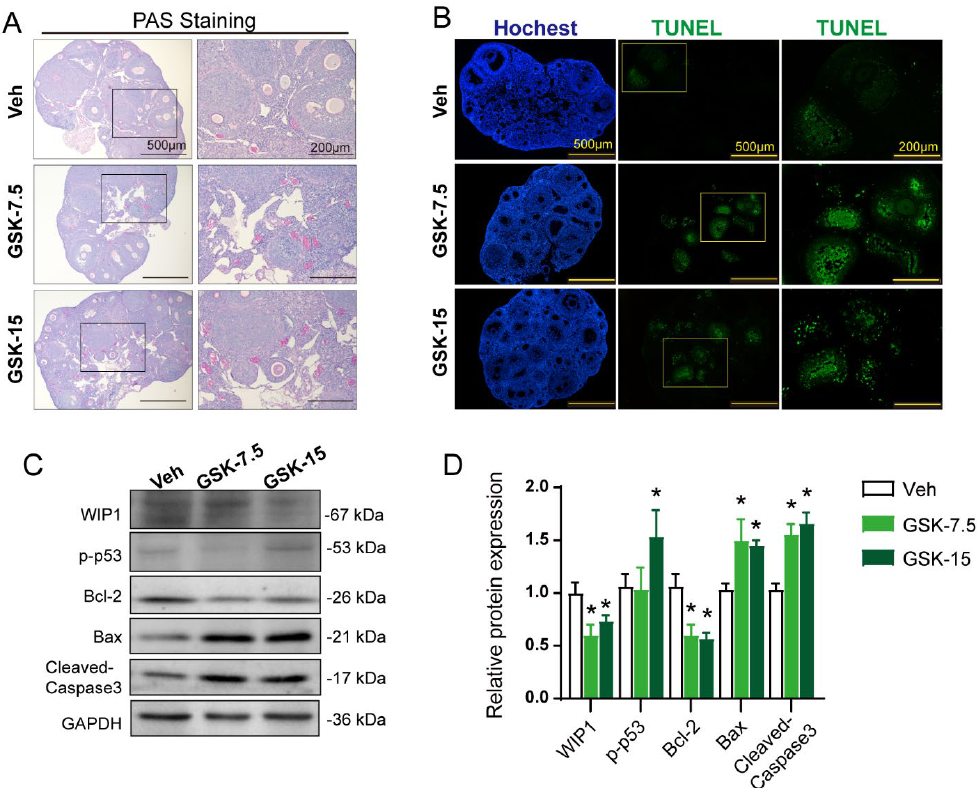
Figure 4. WIP1 inhibitor treatment promoted follicular atresia in mice. ( A ) PAS staining of mouse ovaries with or without GSK2830371 treatment. The ovaries from GSK2830371-treated mice exhibited more PAS positive staining. ( B ) TUNEL staining of mouse ovaries with or without GSK2830371 treatment. The ovaries from GSK2830371-treated mice exhibited more TUNEL positive staining. ( C , D ) Protein expression of apoptosis-related genes detected by Western blot ( n ≥ 3, one-way ANOVA). Data are presented as the mean ± SD. *compared with the Veh group. * p < 0.05. 3.5. Inhibition of WIP1 Activity Impairs the Follicular Growth and Oocyte Quality In Vitro To further clarify the influence of WIP1 on follicular development and atresia, preantral follicles were cultured with WIP1 inhibitor GSK2830371 (0, 0.1, 1.0, 5.0 and 10.0 μM) for six days. To explore the effect of WIP1 on the preantral follicle growth, the follicle morphology was observed and recorded daily (Figure 5A). The analysis of follicular di- ameter suggested that GSK2830371 intervention (1.0, 5.0 and 10.0 μM) could significantly inhibit follicular growth (Figure 5B). The follicles cultured without GSK2830371 or at 0.1 μM GSK2830371 kept growing and exhibited maximal volume at the 6th day of in vitro culture. The cell proliferation was detected by Ki67 staining, and follicles in the GSK group showed a reduction in Ki67 fluorescence intensity (Figure 5C). The TUNEL assay was ap- plied to detect apoptosis in follicles after 4 days in culture. The TUNEL-positive granulosa